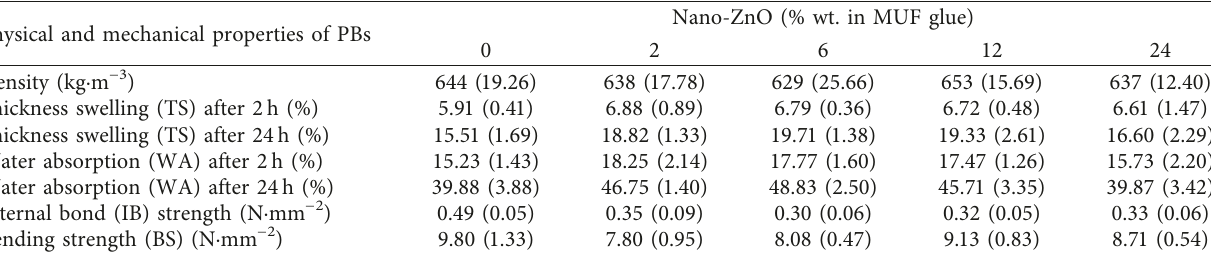
Table 3: Physical and mechanical properties of the control PB and the nano-ZnO-treated PBs. Physical and mechanical properties of